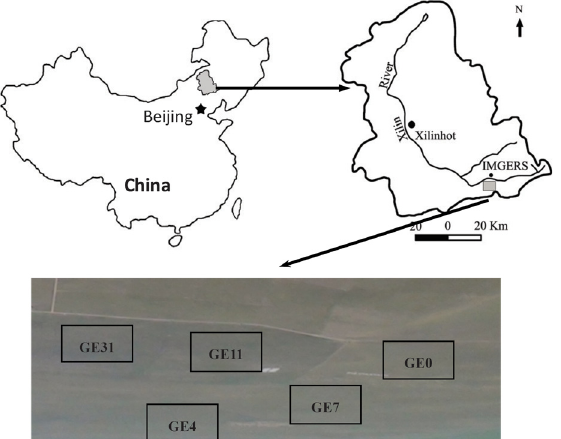
Fig 1. Experimental area and the five experimental plots. IMGERS, Inner Mongolia Grassland Ecosystem Research Station (43°33 0 N, 116°40 0 E). GE0, free grazing grassland; GE4, 4-yr grazing exclusion grassland; GE7, 7-yr grazing exclusion grassland; GE11, 11-yr grazing exclusion grassland; GE31, 31-yr grazing exclusion.